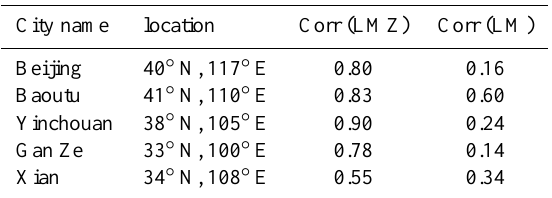
Fig. 4. (a) The forecasted accumulated precipitation for the whole January 1989 using the terrain-following model LM; (b) as (a) , observed according to the GPCC (land) and GPCP (ocean) datasets; (c) as (a) , for the cut-cell model LMZ; (d) as (a) , for the terrain-following model CLM in its current version. For (c) and (d) , the same colour scheme as for (b) was used. The lines and the numbers 1 to 4 in (b) denote the areas used to calculate the precipitation biases. Table 2. Temperature anomaly correlations for LMZ and LM for selected